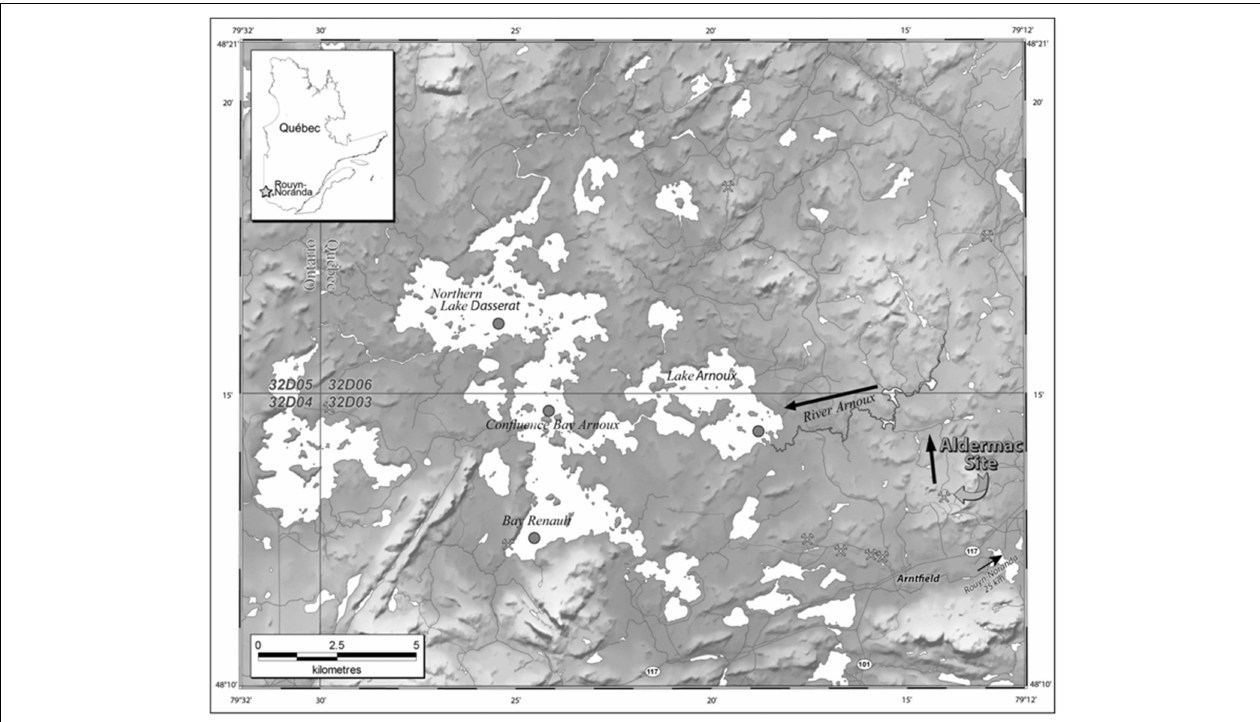
FIGURE 1 | Locations of the former Aldermac mine and the sampling stations (gray dots) downstream in Lake Arnoux and Lake Dasserat. Black arrows identify surface water drainage flow from the abandoned mining site. Map sheets for this figure are 32D03, 04, 05, 06.